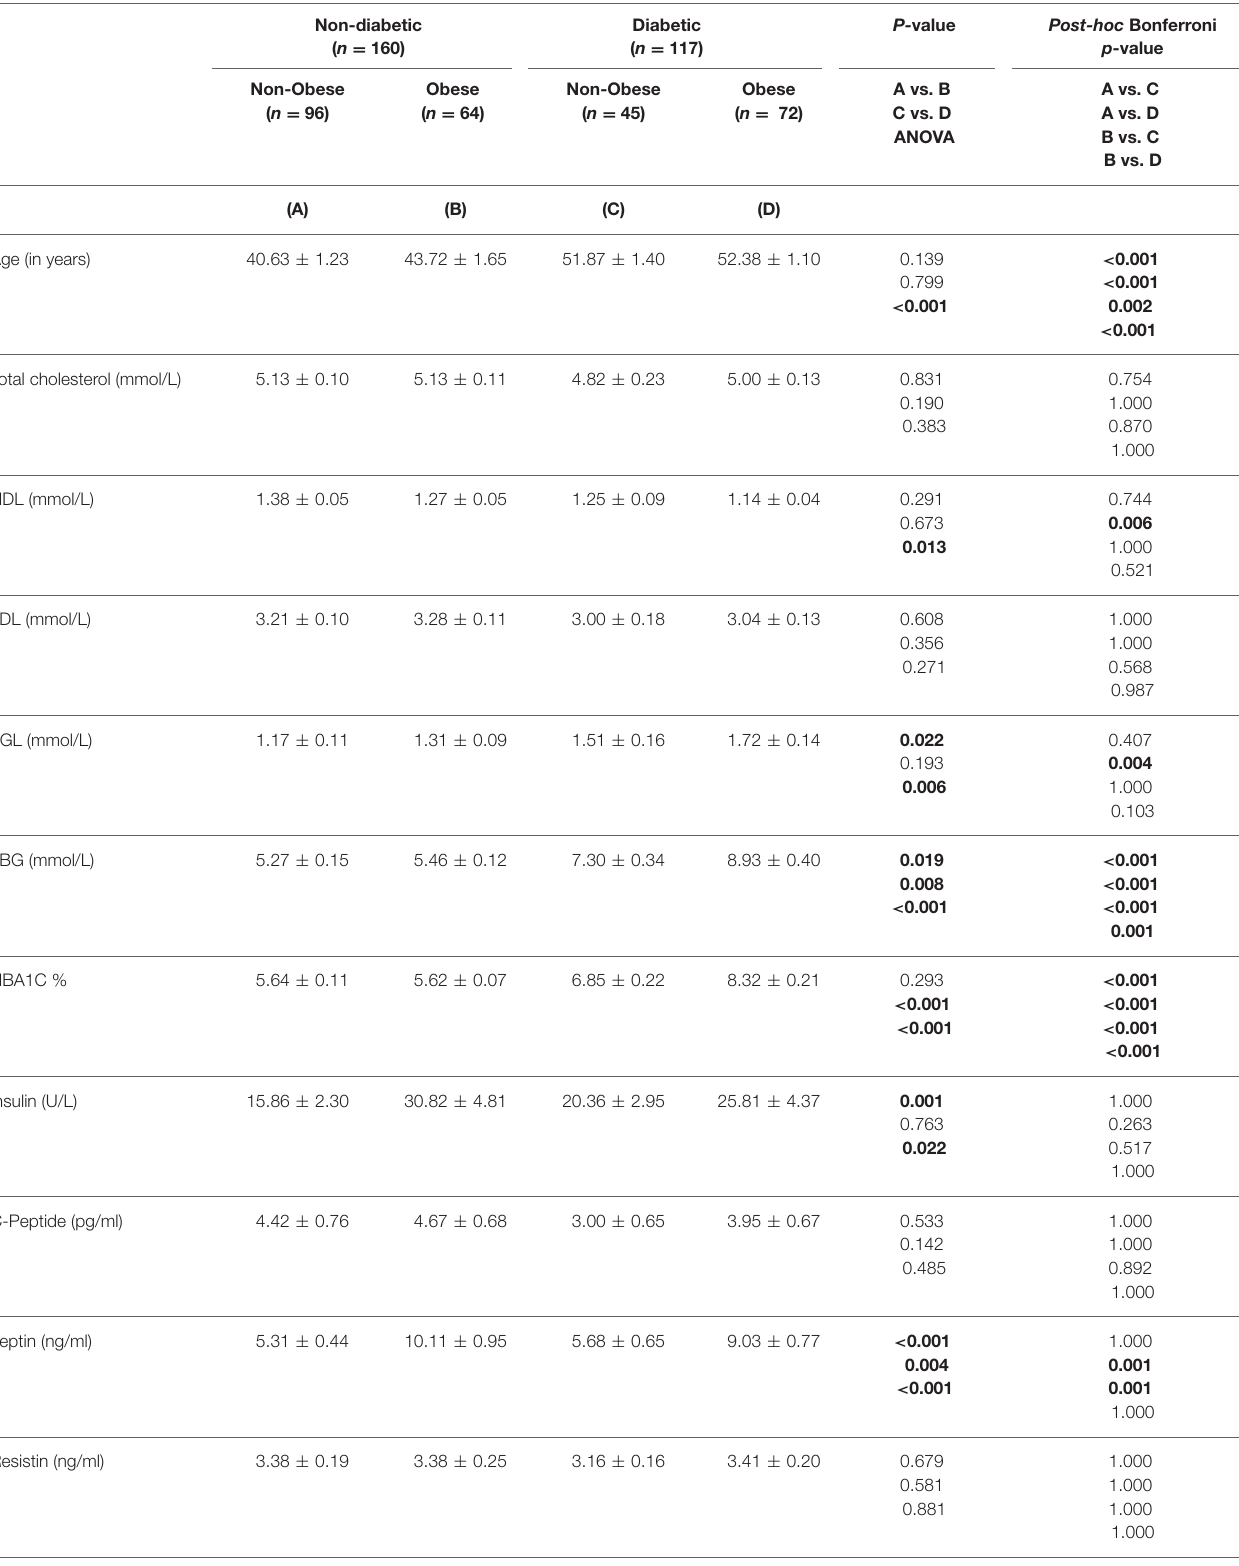
TABLE 2 | Physical and Biochemical characteristics of the non-diabetic and diabetic population categorized based on